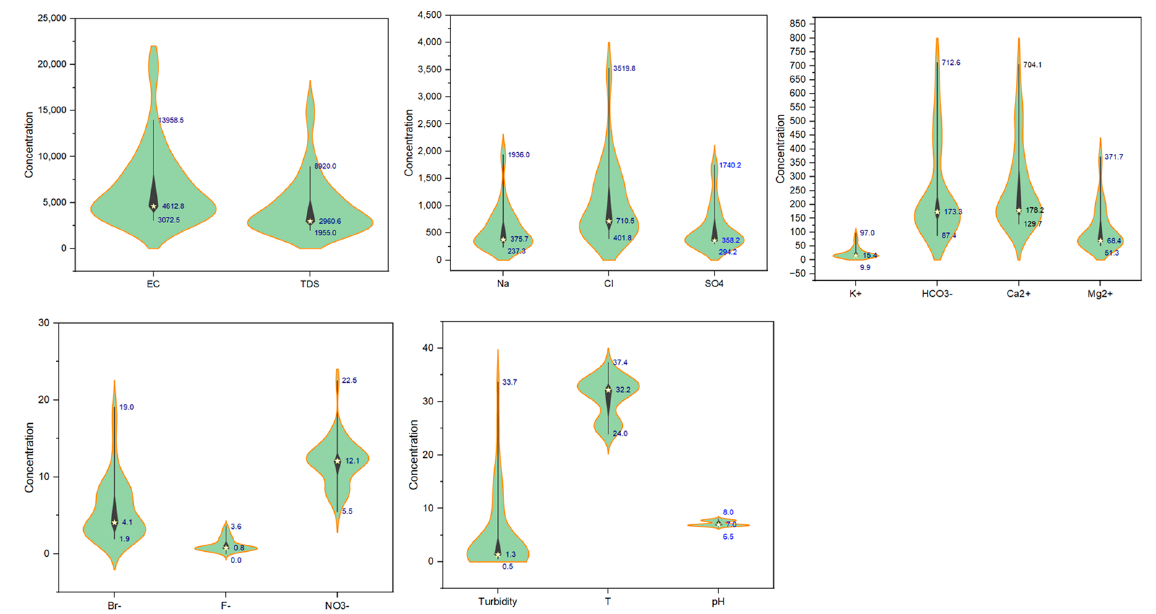
Figure 3. Violin plots showing the statistics and distribution of the physical and chemical parameters of the tested GW.